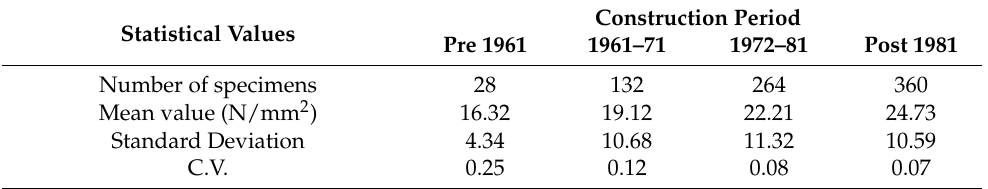
Table 6. Mean value and standard deviation of concrete strength (f c ) in different construction periods.